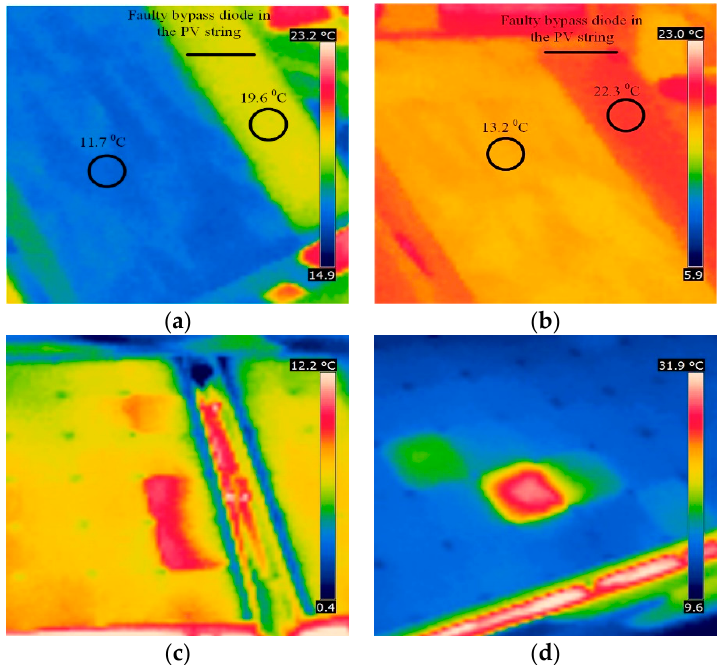
Figure 7. Impact of high ambient temperature and solar radiation on the examined PV sites in Australia, images were taken using FLIR E4 thermal imaging camera: ( a ) faulty bypass diode in a PV string increasing the temperature of the PV string by 7.9 °C; ( b ) faulty bypass diode in a PV string increasing the temperature of the PV string by 9.1 °C; ( c ) PV hot spots found in a PV module in site F (Newcastle, Australia); ( d ) more PV hot spots found in a different PV module in PV site F. In order to visualize the impact of the failure in the bypass diodes, as well as the hot-spots in the Australian PV sites, we have carried out the analysis of the sub-array of the affected PV installations. Figure 8a shows the sub-array of the PV installation located in Albury, where two PV modules affected by faulty bypass diodes is observed in the PV array 2. According to Figure 8b, the Newcastle PV system has five hot-spotted PV modules in the first PV array, while the second PV array is only affected by one hot-spotted PV module.